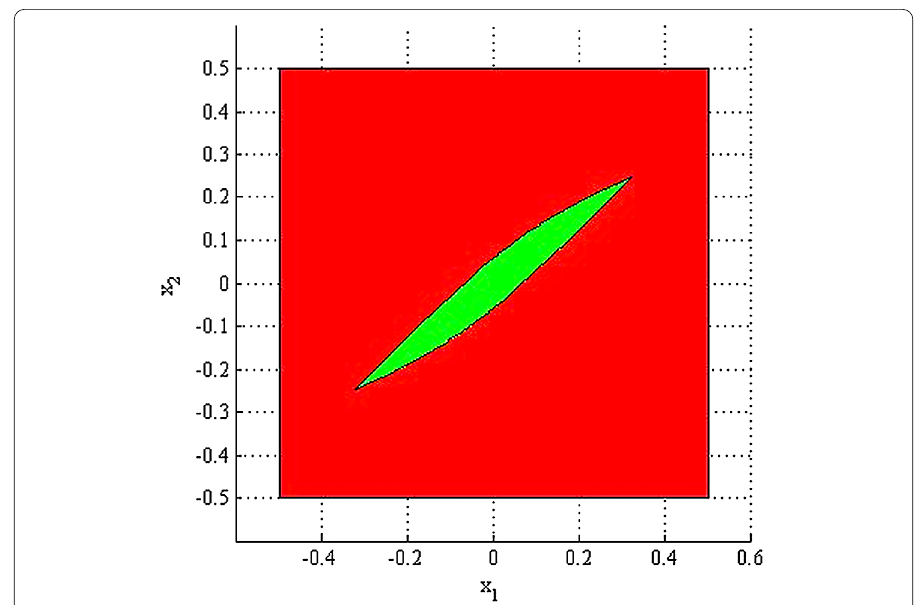
Figure 2 Viability constraint (5.3) (red) and the corresponding viability kernel (green) for (5.4) by using Algorithm